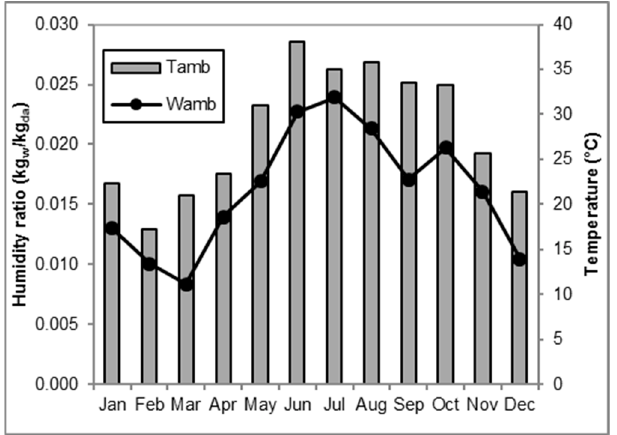
Figure 4. Monthly mean ambient temperature and humidity ratio.